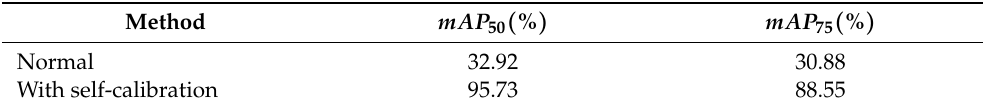
Table 2. Comparison of screw positioning results with and without autonomous adjustment of screw